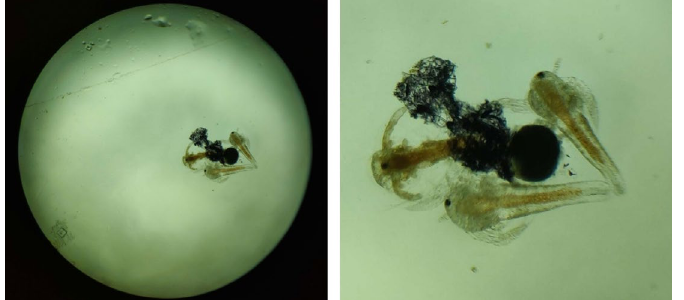
Fig. 3. Light microscope - A.nauplii : 40X (left) , 10X (right); represents the microscopic image of the brine shrimp attached to a gold